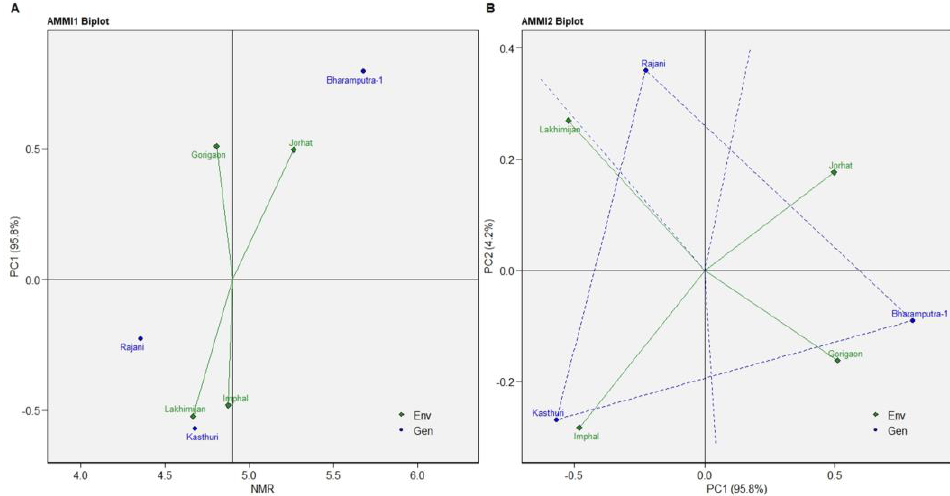
Figure 3. ( A ) AMMI1 biplot ( B ) AMMI2 biplot for number of primary rhizomes. Again, for NMR, the Rajani and Kasthuri varieties were more stable than Bharam- putra-1 (Figure 4A). The variety Kasthuri was best suitable for Imphal, Rajani variety for Lakhimijan, and Bharamputra-1 for Jorhat and Gorigaon, as revealed through AM- MI2 biplot analysis of NMR (Figure 4B).